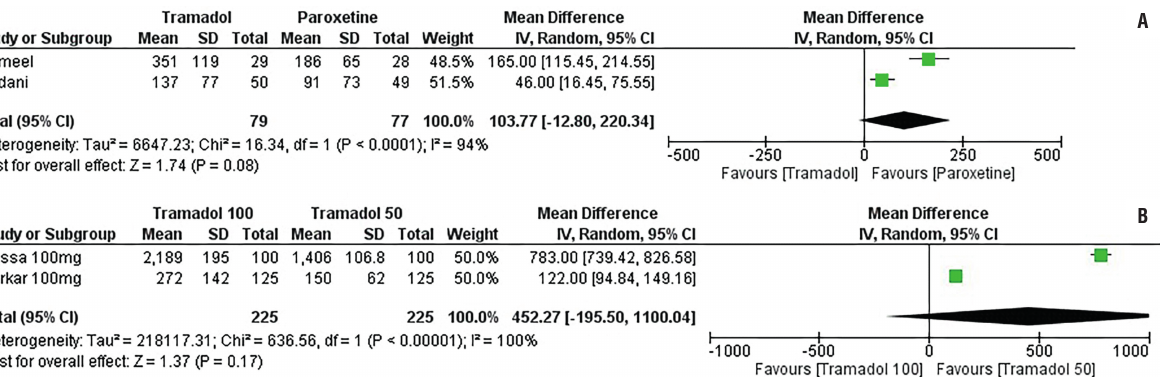
Figure 5 - Forest plot depicting comparison of Tramadol versus paroxetine (a) and tramadol 50mg versus 100mg (b).